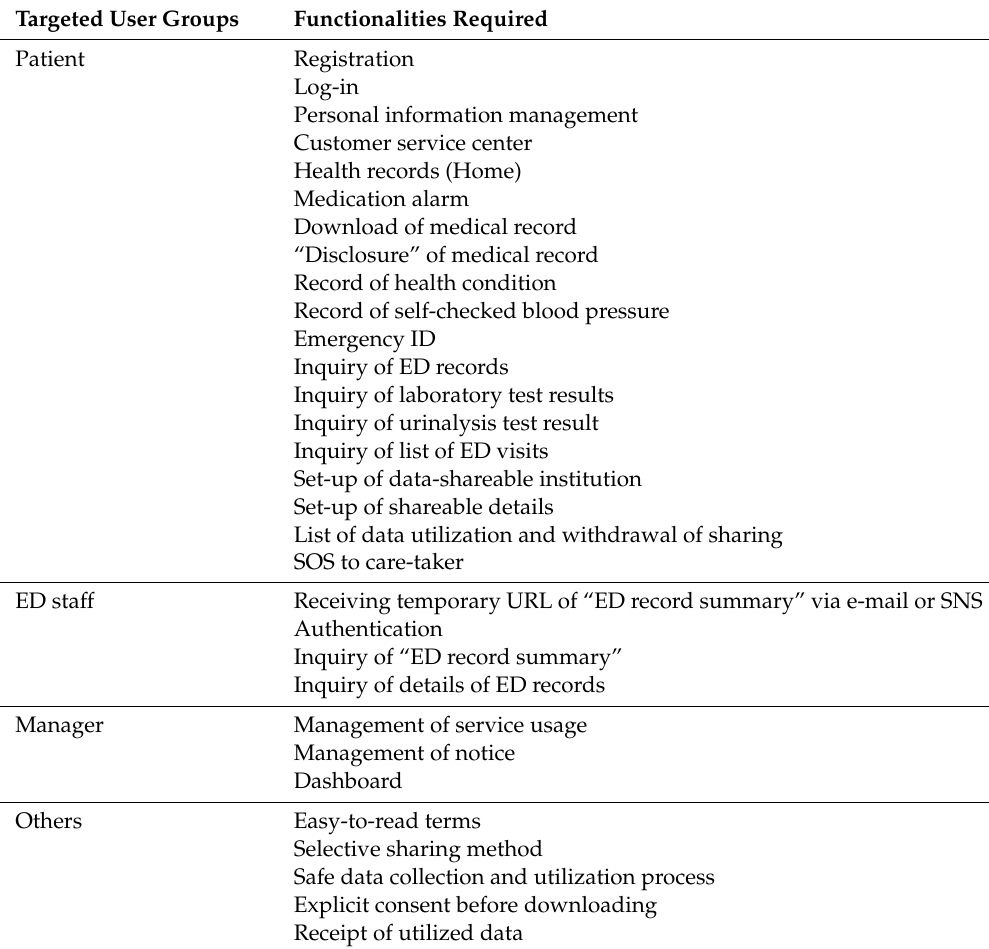
Table 1. Functionalities required for targeted user